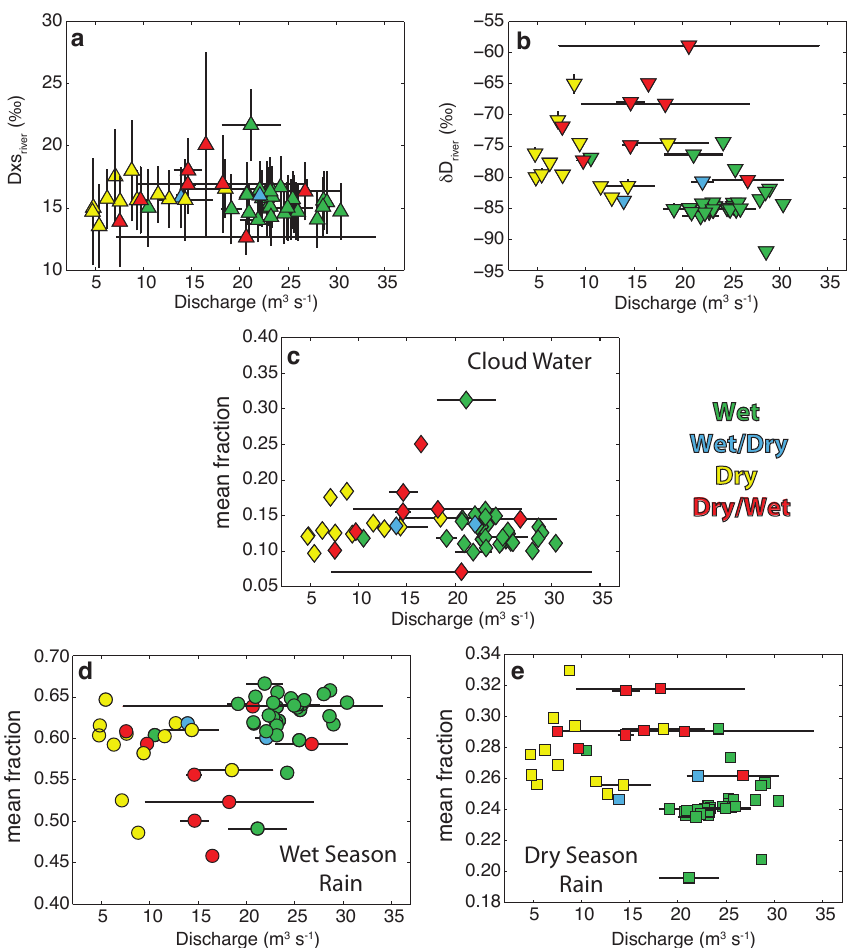
Figure 7. Variation in the isotopic composition of river water (a) deuterium excess (Dxs river , ‰) and (b) hydrogen isotope ratio ( δ D river , ‰) plotted versus discharge (m 3 s − 1 ) . Variation in the mean contributions to river flow as a function of water discharge for cloud water vapour (c) , wet-season rain (d) , and dry-season rain (e) , all as calculated by the endmember mixing